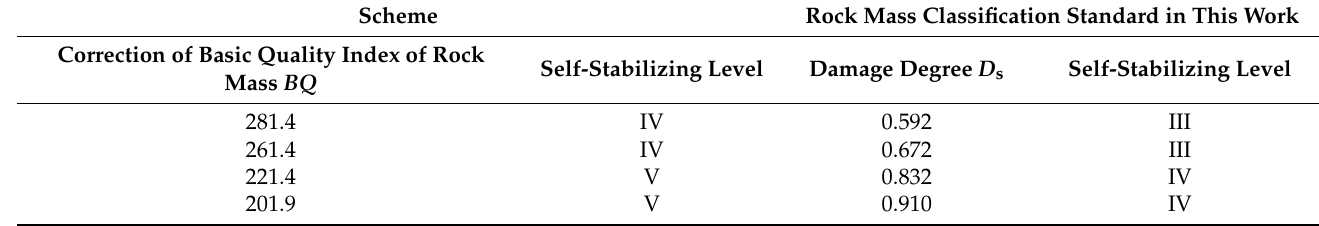
Table 8. Comparison of the self-stabilizing parameters of the rock mass.